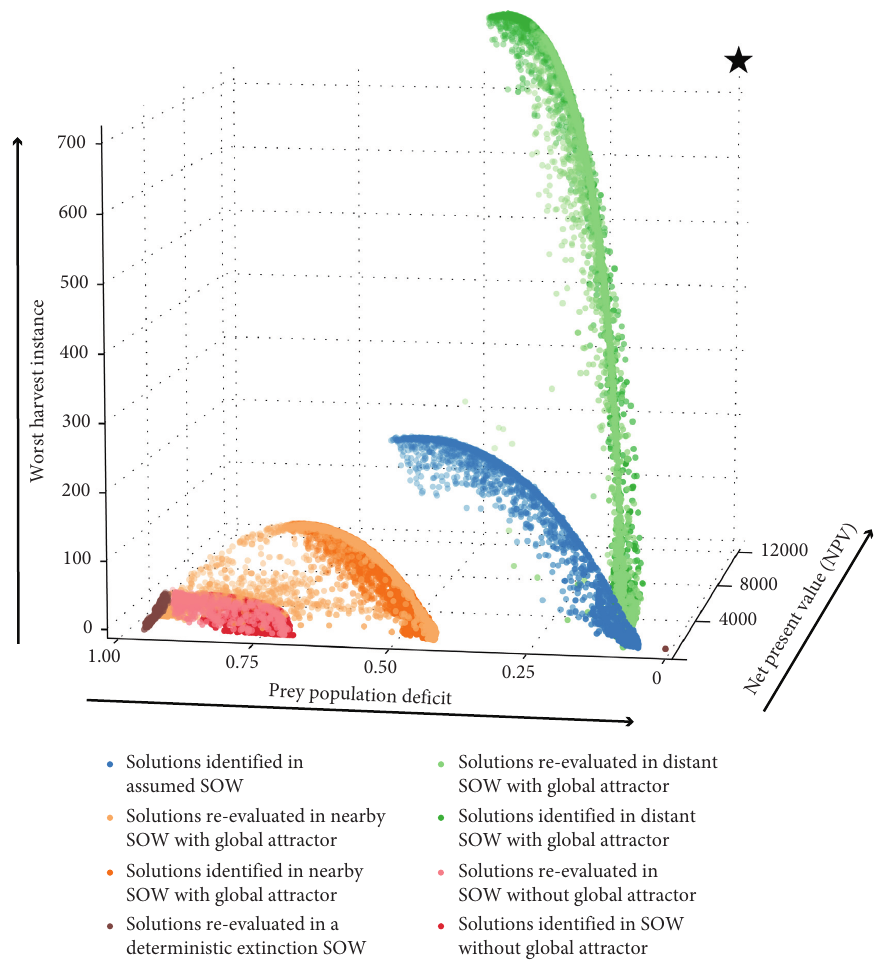
Figure 4: Solutions as points in a 3D objective space. Blue: as identified in the assumed SOW; brown: re-evaluated in a SOW with deterministic extinction; light red: re-evaluated in nearby SOW without a global attractor; light orange: re-evaluated in nearby SOW with global attractor; light green: re-evaluated in distant SOW with global attractor. Dark red, dark green, and dark orange represent the solutions identified when optimizing to those SOWs. The parameter values for each SOW are provided in Table